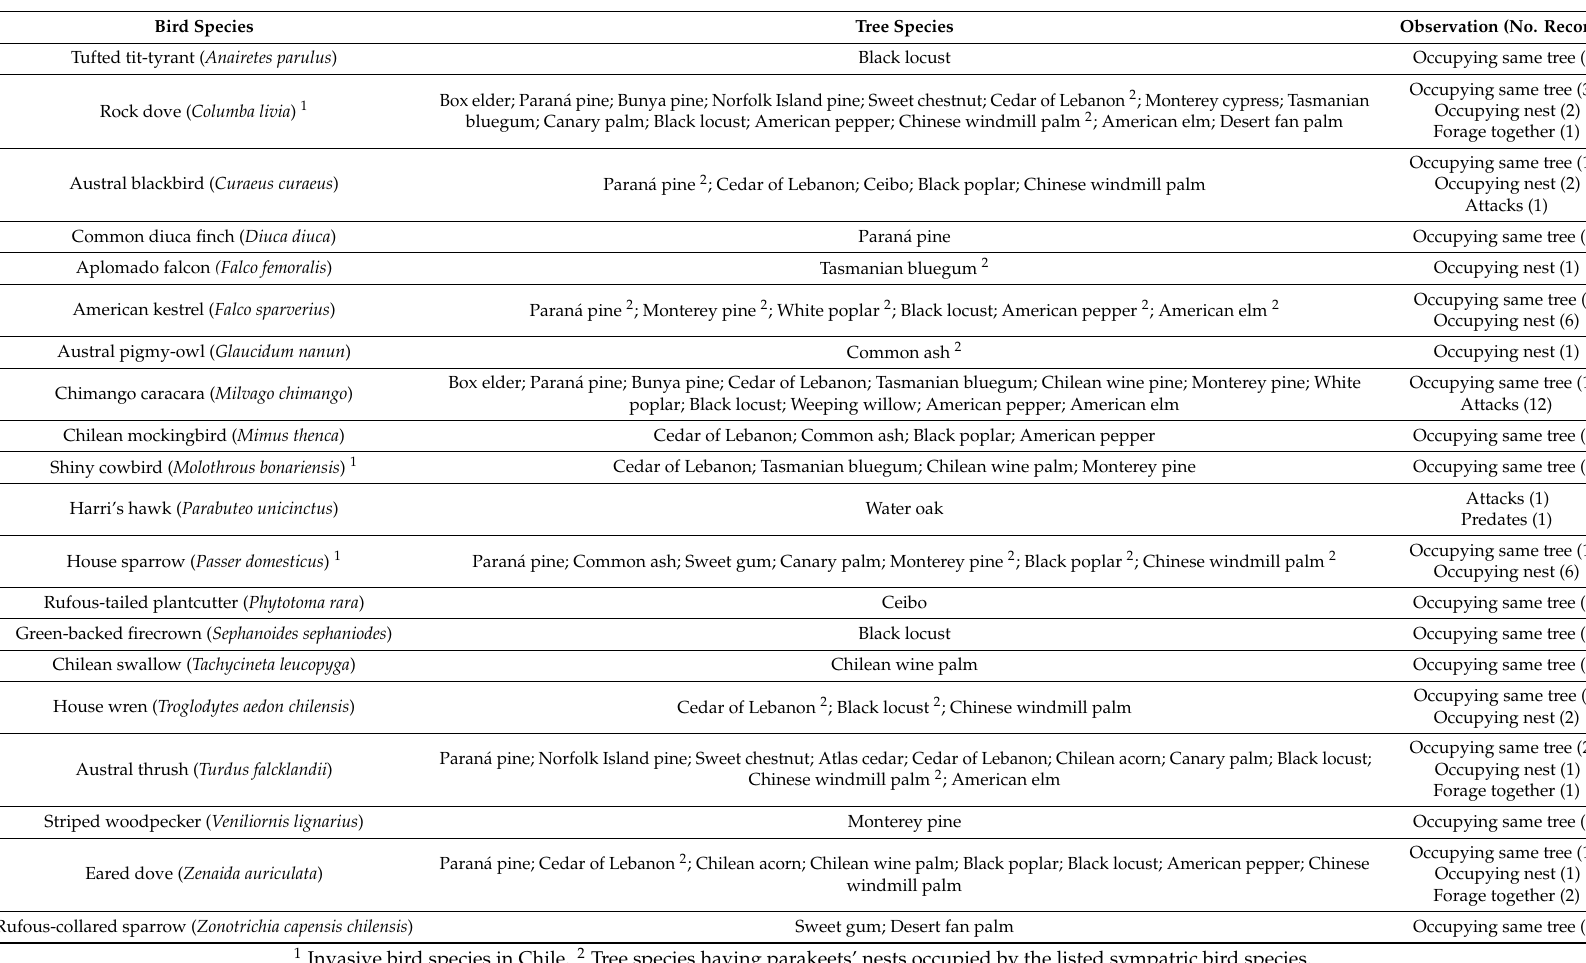
Table 2. Observations of introduced monk parakeets surrounding their nest and resident bird species, between 15 August and 21 December of 2017 and 2018 in Santiago, Chile. Latin name of tree species are given in the Table